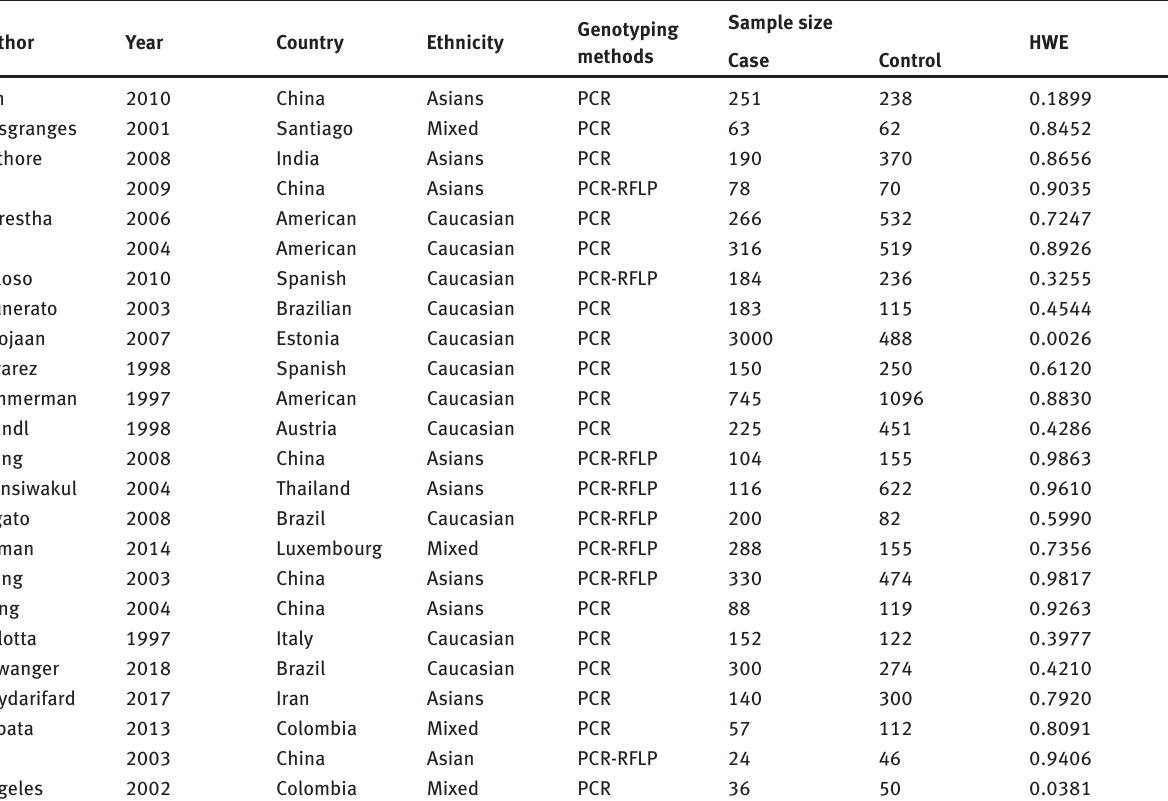
Table 1: Main characteristics of studies included in the meta-analysis